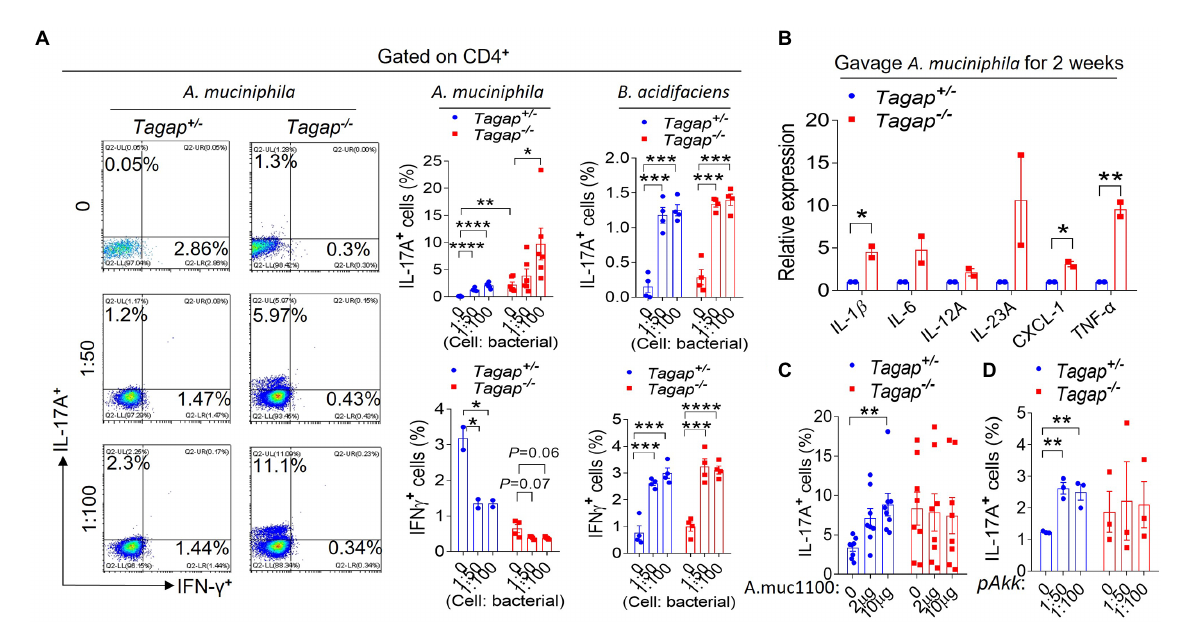
FIGURE 5 Akkermansia muciniphila or Bacteroides acidifaciens promote T helper cells polarization. (A) Littermate control mice or TAGAP-deficient mice were oral gavaged A. muciniphila twice a week for 2 weeks (1 × 10 9 ), and cells were isolated from lamina propria, and incubated with A. muciniphila or B. acidifaciens for another 3 days (MOI = 50 or 100). Cells were analyzed by flow cytometry as indicated. (B) Littermate control mice or TAGAP- deficient mice were oral gavaged A. muciniphila twice a week for 2 weeks (1 × 10 9 ). Colonic tissues were isolated, followed by real-time PCR analysis of indicated gene expression. (C) Littermate control mice or TAGAP-deficient mice were oral gavaged Amuc_1100 twice a week for 2 weeks (10 μ g/mouse), and cells were isolated from lamina propria, and incubated with Amuc_1100 for another 3 days (2 μ g/ml or 10 μ g/ml). Cells were analyzed by flow cytometry as indicated, n = 8. (D) Littermate control mice or TAGAP-deficient mice were oral gavaged pasteurized A. muciniphila twice a week for 2 weeks (1 × 10 9 ), and cells were isolated from lamina propria, and incubated with pasteurized A. muciniphila for another 3 days (MOI = 50 or 100). Cells were analyzed by flow cytometry as indicated. * p < 0.05, ** p < 0.01, *** p < 0.001, **** p < 0.0001 based on unpaired T test (C,D) . Data are representative of three independent